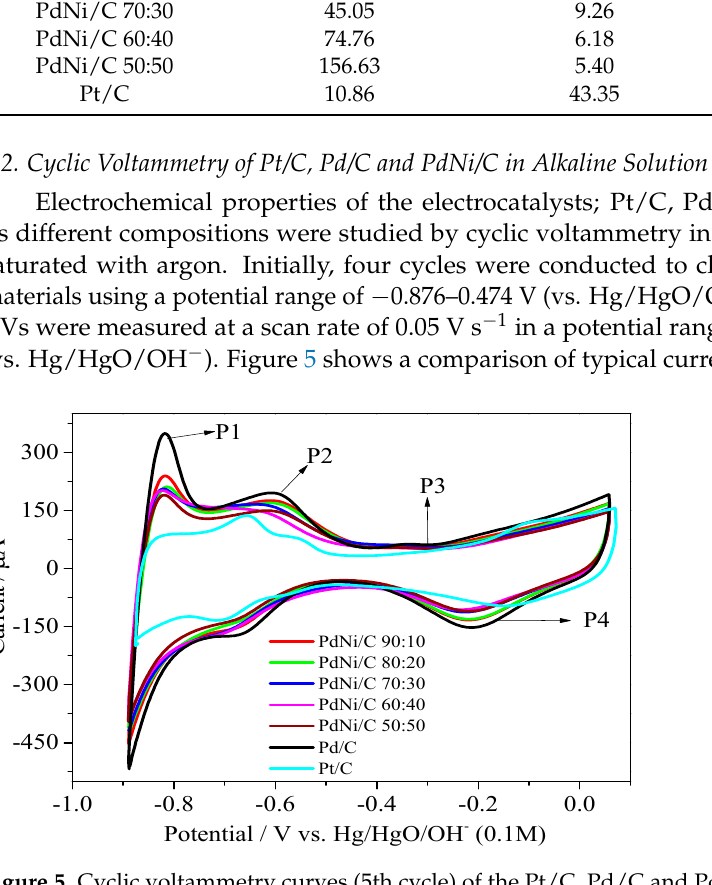
Figure 5. Cyclic voltammetry curves (5th cycle) of the Pt/C, Pd/C and PdNi/C catalysts in argon- saturated electrolyte, 0.1 M NaOH. Sweep rate: 0.05 V s − 1 , where: P represents peak.